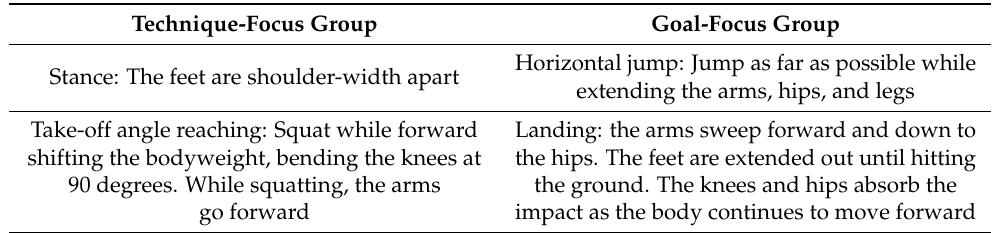
Table 5. Based on the group (technique-focus or goal-focus), different subcomponents of the SLJ performance were shown in the video demonstrations.